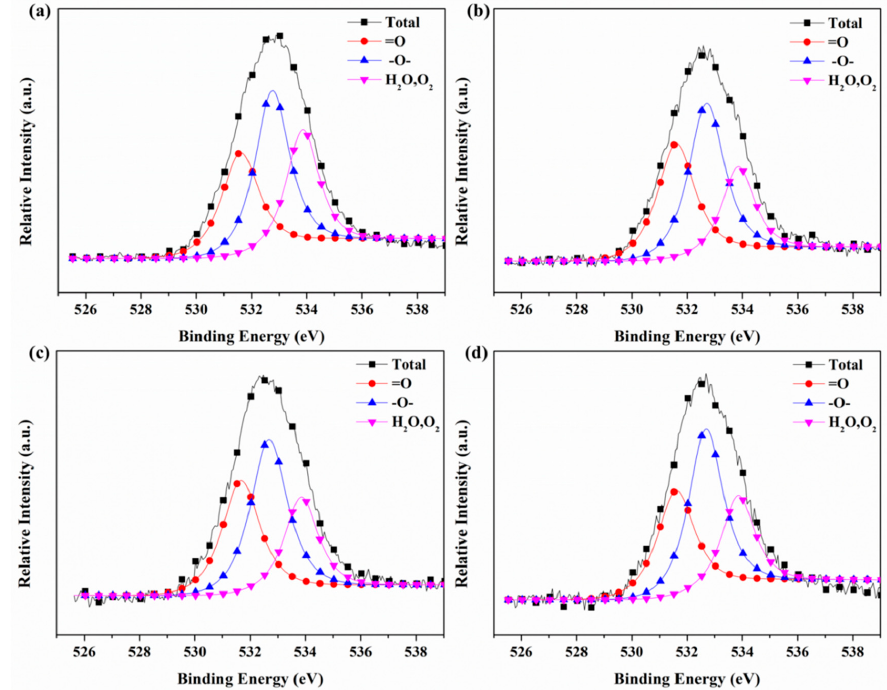
Figure 10. O1s spectra of each carbonaceous deposit layer in the coking chamber: ( a ) #1 carbonaceous deposit layer; ( b ) #2 carbonaceous deposit layer; ( c ) #3 carbonaceous deposit layer; and ( d ) #4 carbonaceous deposit